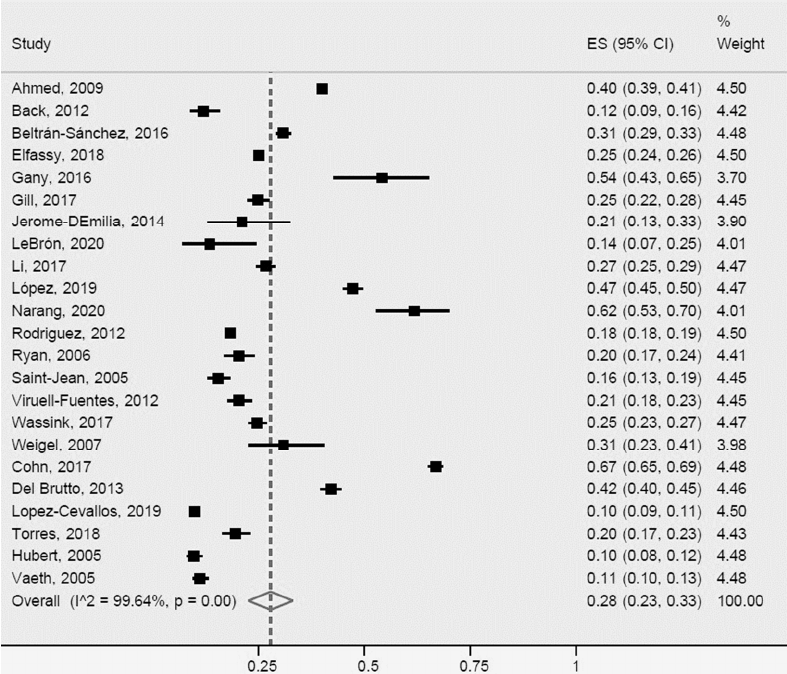
Figure 2. Arterial hypertension or high blood pressure for Latinos in the US. ES = Estimated proportion/prevalence; CI = Confidence interval; I^2 = I 2 index. Additionally, a meta ‐ analysis of the prevalence of arterial hypertension or high